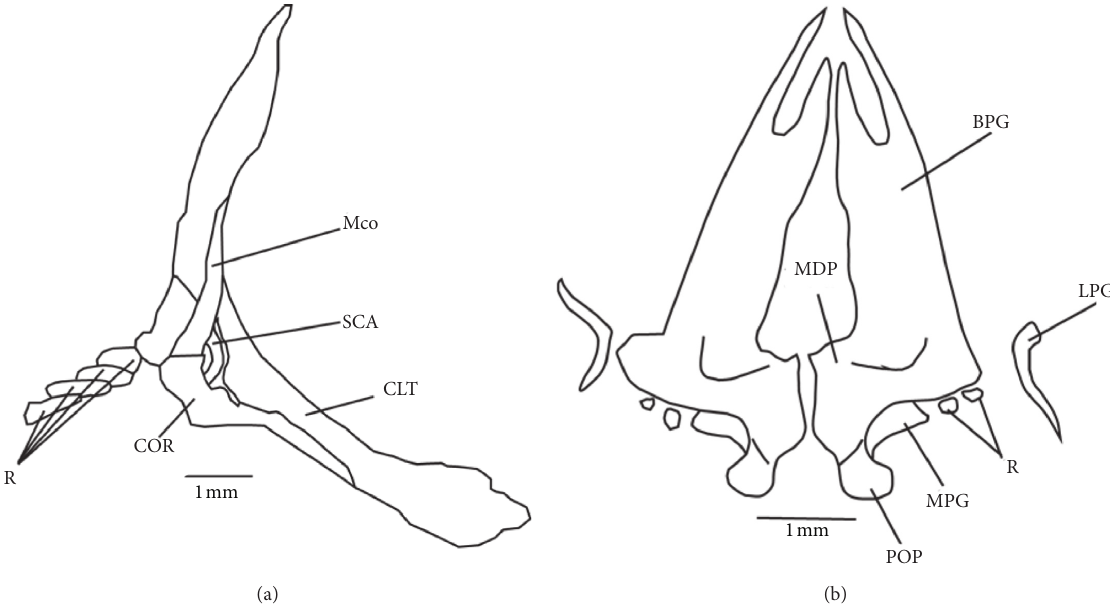
Figure 6: (a) Internal view of the pectoral girdle, and (b) ventral view of the pelvic girdle of G . rossica . BPG: basipterygium; CLT: cleithrum; COR: coracoid; LPG: lateral pterygium; Mco: mesocoracoid; MDP: medial process; MPG: metapterygium; POP: posterior process; R: radials; SCA: